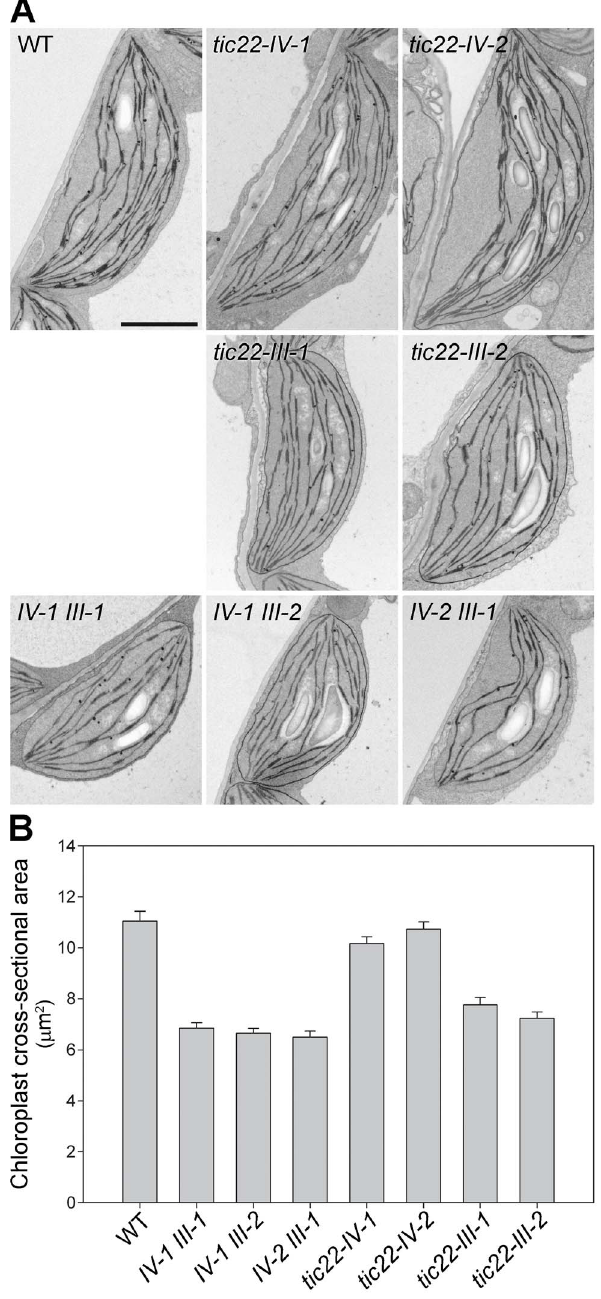
Figure 5. Analysis of plastid ultrastructure in the tic22 single and double mutants. A. Cotyledons of 5-day-old plants were analysed by transmission electron microscopy. On average, , 20 whole-chloroplast micrographs from each of three (two in the case of tic22-IV-2 tic22-III-1 ) independent plants per genotype (a minimum of 50 chloroplasts per genotype) were analysed for each genotype, and used to select the representative images shown. Size bar=1.0 m m. B. Cross sectional area ( m m 2 ) of chloroplasts from the cotyledons of wild type and the tic22 mutants was determined by the analysis of the micrographs described in A. At least 50 chloroplasts were measured for each genotype.